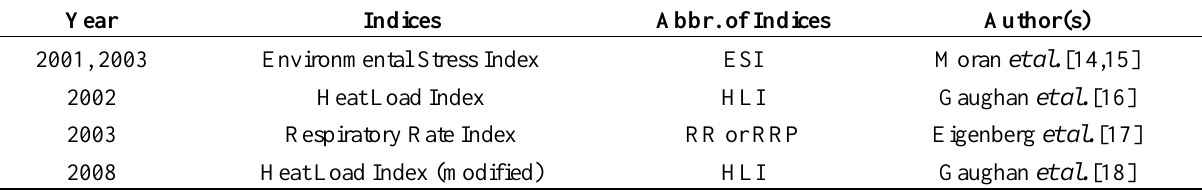
Table 1. Published studies of climatic indices in different regions of the